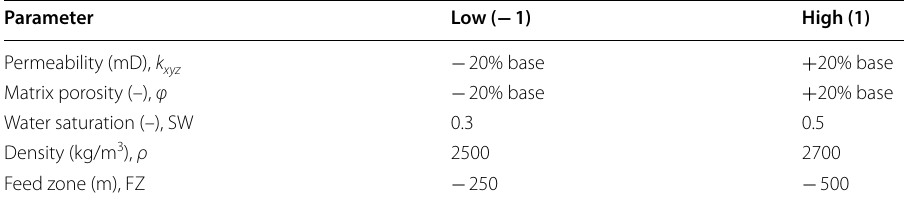
Table 4 Uncertain parameters to be tested on the K–TB model using the ED and RSM workflow of full factorial/Plackett–Burman Parameter